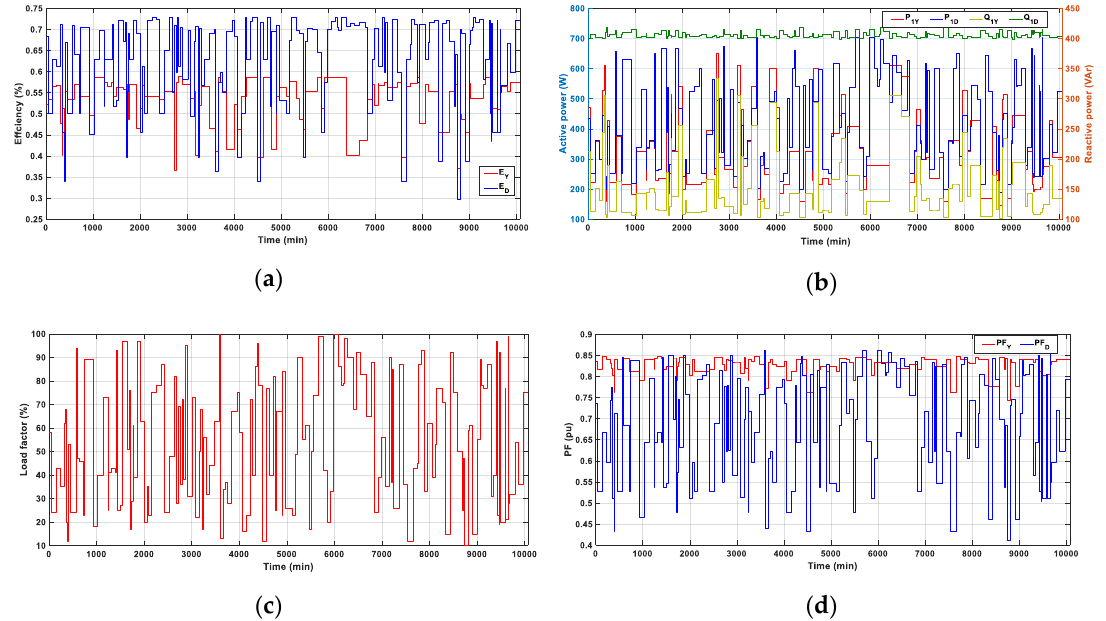
Figure 12. Weekly study of IM 0.37 kW (IMEMSL #1): ( a ) Energy efficiency; ( b ) Active and reactive power; ( c ) Load factor; ( d ) Power factor.